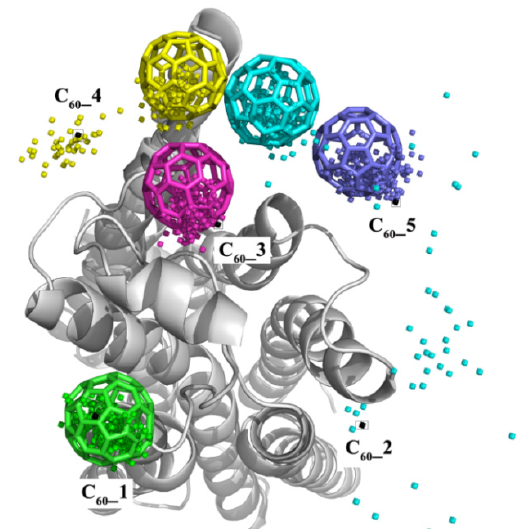
Figure 7. The trajectory of five fullerene molecules in the 5C 60 _ex system (top view); different colors represent different fullerene molecules. Each dot represents the average position (center of mass) of C 60 along the MD trajectory, sampled every 1 ns. The black dots represent the initial positions and the colored stick is the final position of C 60 .